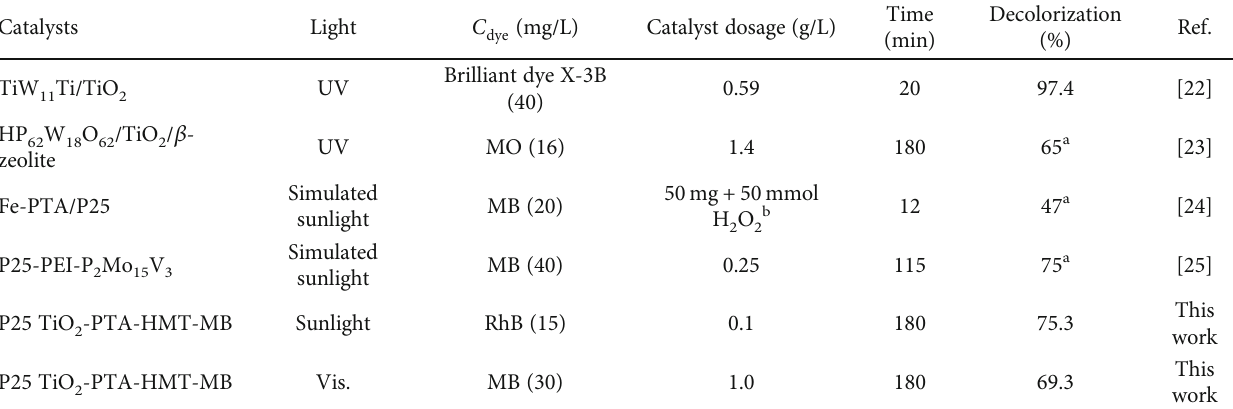
-PTA-HMT-MB and reported P25 TiO 2